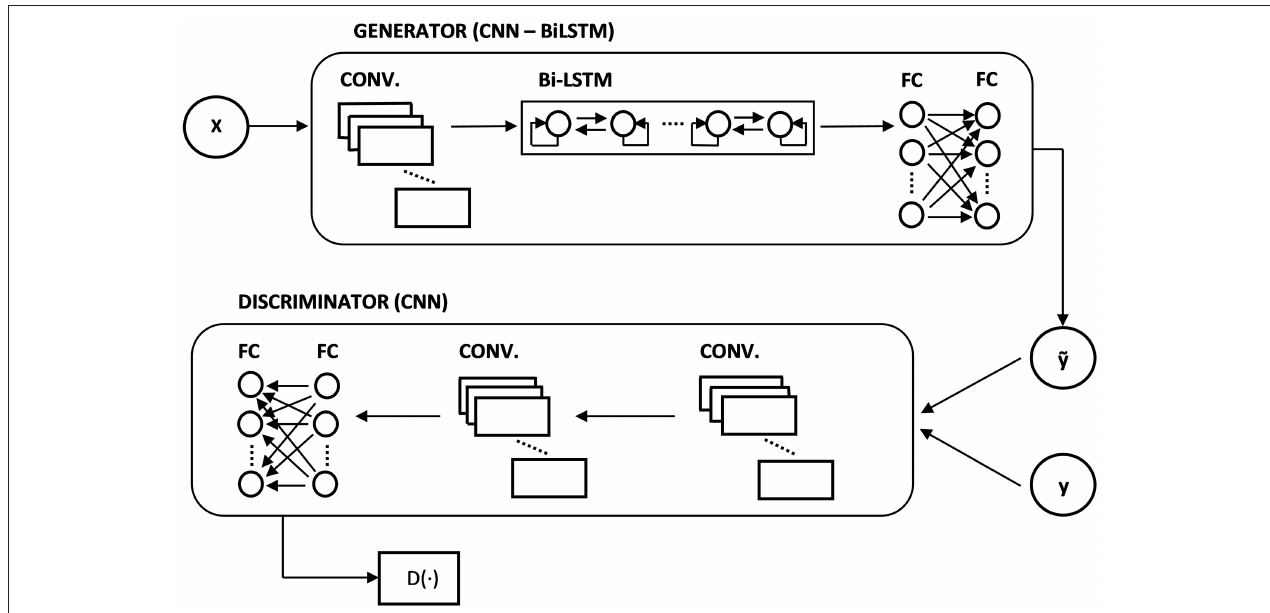
FIGURE 2 | Stylized architecture of our DCGAN.